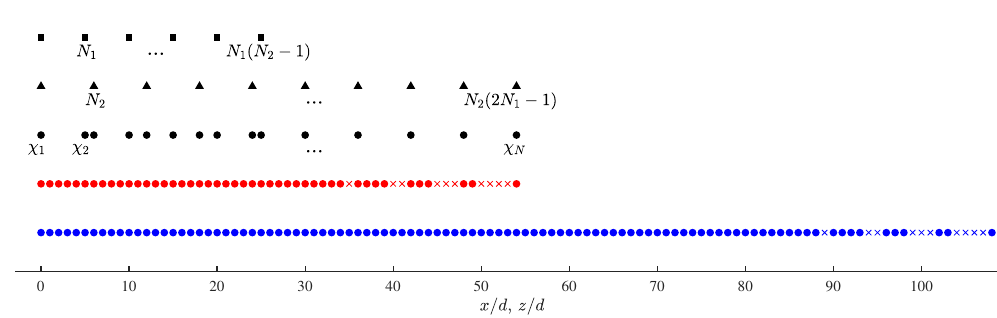
Figure 2. Configuration of CPA( N 1 , N 2 ), N 1 = 5, N 2 = 6, (cid:4) : first ULA at spacing N 1 d , (cid:78) : second